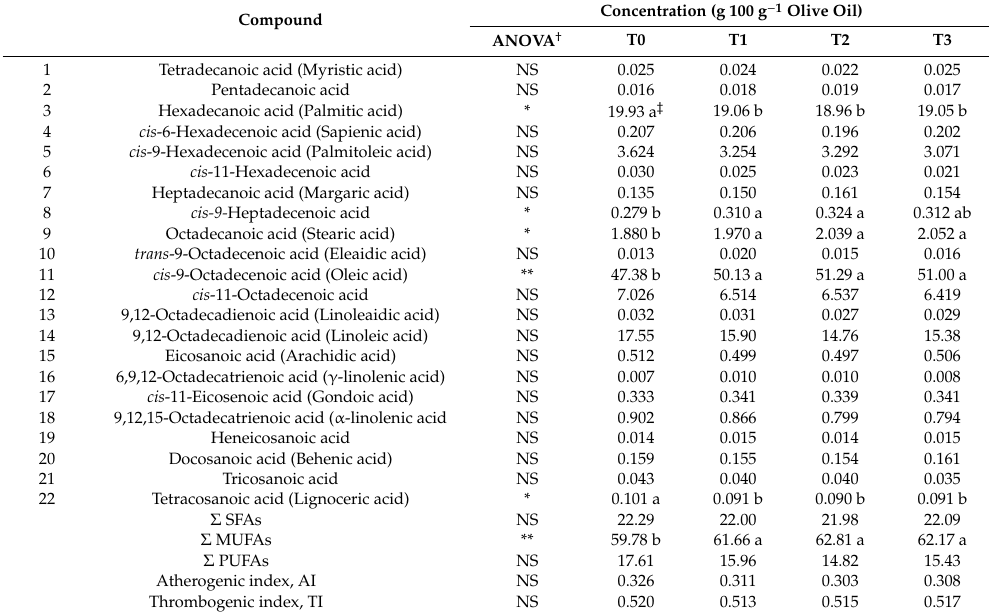
Table 2. Fatty acid profiles of “Arbequina” olive oil as a ff ected by the irrigation treatment.